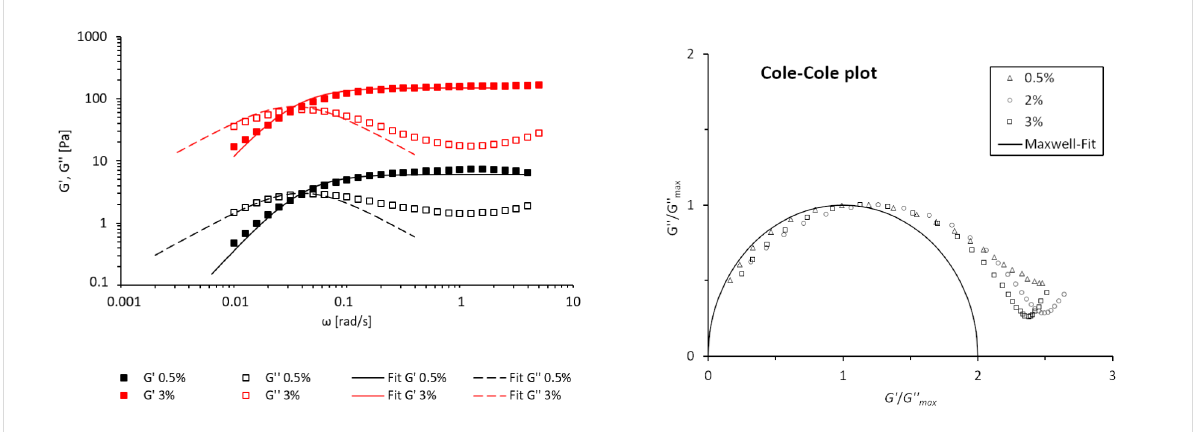
Figure 5: Frequency sweep: double logarithmic plot of the dynamic moduli against the frequency for the dirhamnolipid ethyl ester 2 at different con- centrations in toluene at 15 °C and an amplitude of 0.2% (left), and the Cole–Cole plot for different concentrations as well as the Maxwell fit.